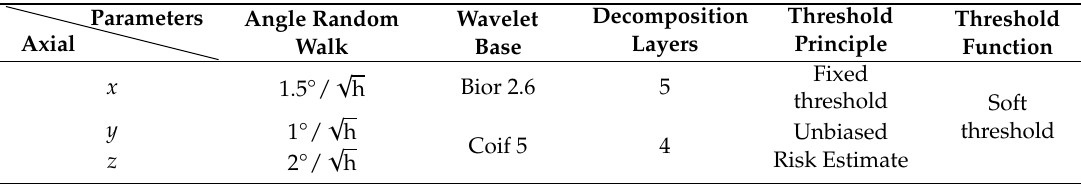
Table 1. Simulation parameters.